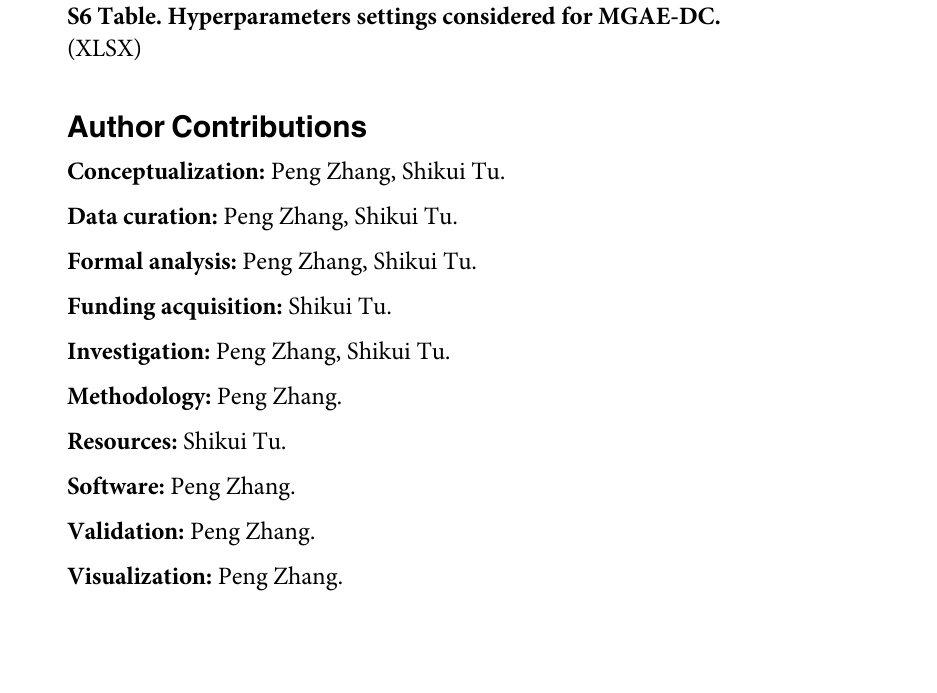
S1 Fig. Visualization of drug Dinaciclib and MK-4541 cell line-specific embeddings in 2-dimensional space using t-SNE. S1 Table. The performances of different methods on the ALMANAC dataset. S2 Table. The performances of different methods on the CLOUD dataset. S3 Table. The performances of different methods on the FORCINA dataset. S4 Table. The performances of different methods using different cross-validation strate- gies. S5 Table. The detailed information of existing methods. S6 Table. Hyperparameters settings considered for